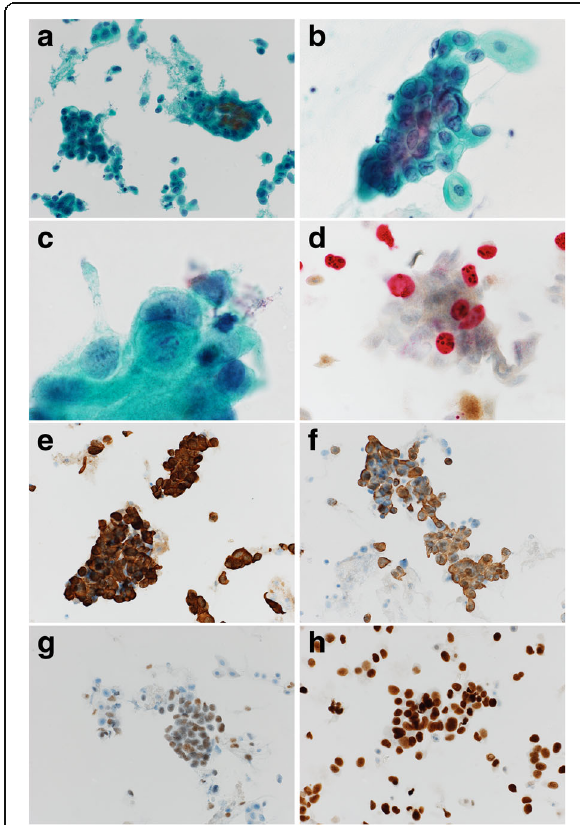
Fig. 1 Photomicrographs of pagetoid urothelial intraepithelial neoplasia extending to the vagina. a – h Liquid-based cytology by vaginal scraping. a Stratified or linear clusters of atypical cells with partially necrotic changes (Papanicolaou [Pap] stain, × 200). b Cluster exhibiting nuclear stratification and disarrangement with cytoplasmic vacuoles and enlarged nucleoli (Pap, × 400). c Cell cannibalism in the margin of the cluster (Pap, × 1000). d CINtec® PLUS test demonstrating positive red nuclear labeling with Ki-67, but weak brown staining for p16 considered negative (immunocytochemical [ICC] stain, × 400). e Positivity for CK7 (ICC, × 200). f Positivity for CK20 (ICC, × 200). g Positivity for p63 (ICC, × 200). h Positivity for GATA3 (ICC, ×